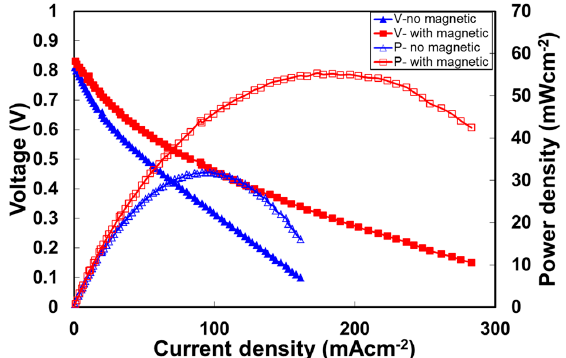
Figure 6. DMAFC voltage (left axis) and power density (right axis) as a function of the current density at 60 °C using CL-QPVA/GO-Fe 3 O 4 composites prepared with and without the magnetic field. GDEs: catalysts of 6 mg·cm − 2 Pt-Ru/C for the anode and 5 mg·cm − 2 Pt/C for the cathode on MPL-free carbon cloth. Anode fuel: 2 M methanol in 6 M·KOH with a flow rate of 5 mL·min − 1 , cathode: humidified oxygen with a flow rate of 100 mL·min − 1 .